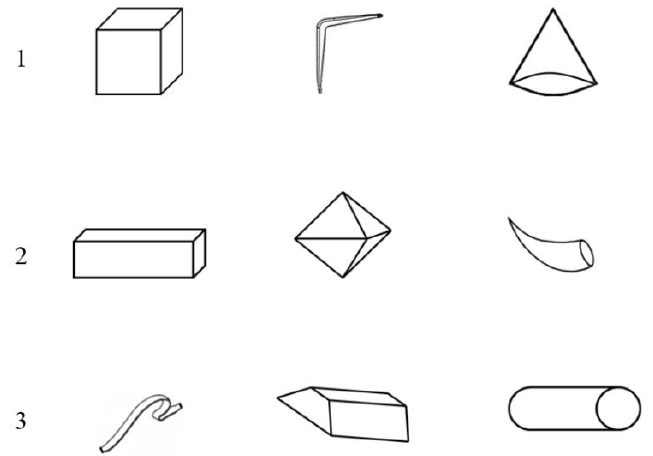
Figure 2. The three triads of components for the Visual Creative Synthesis Task (VCST): ( 1 ) cube, bracket, cone (sport goods); ( 2 ) parallelepiped, dy-pyramid, horn (furniture); ( 3 ) strip, trapezoid, cylinder (weapons).